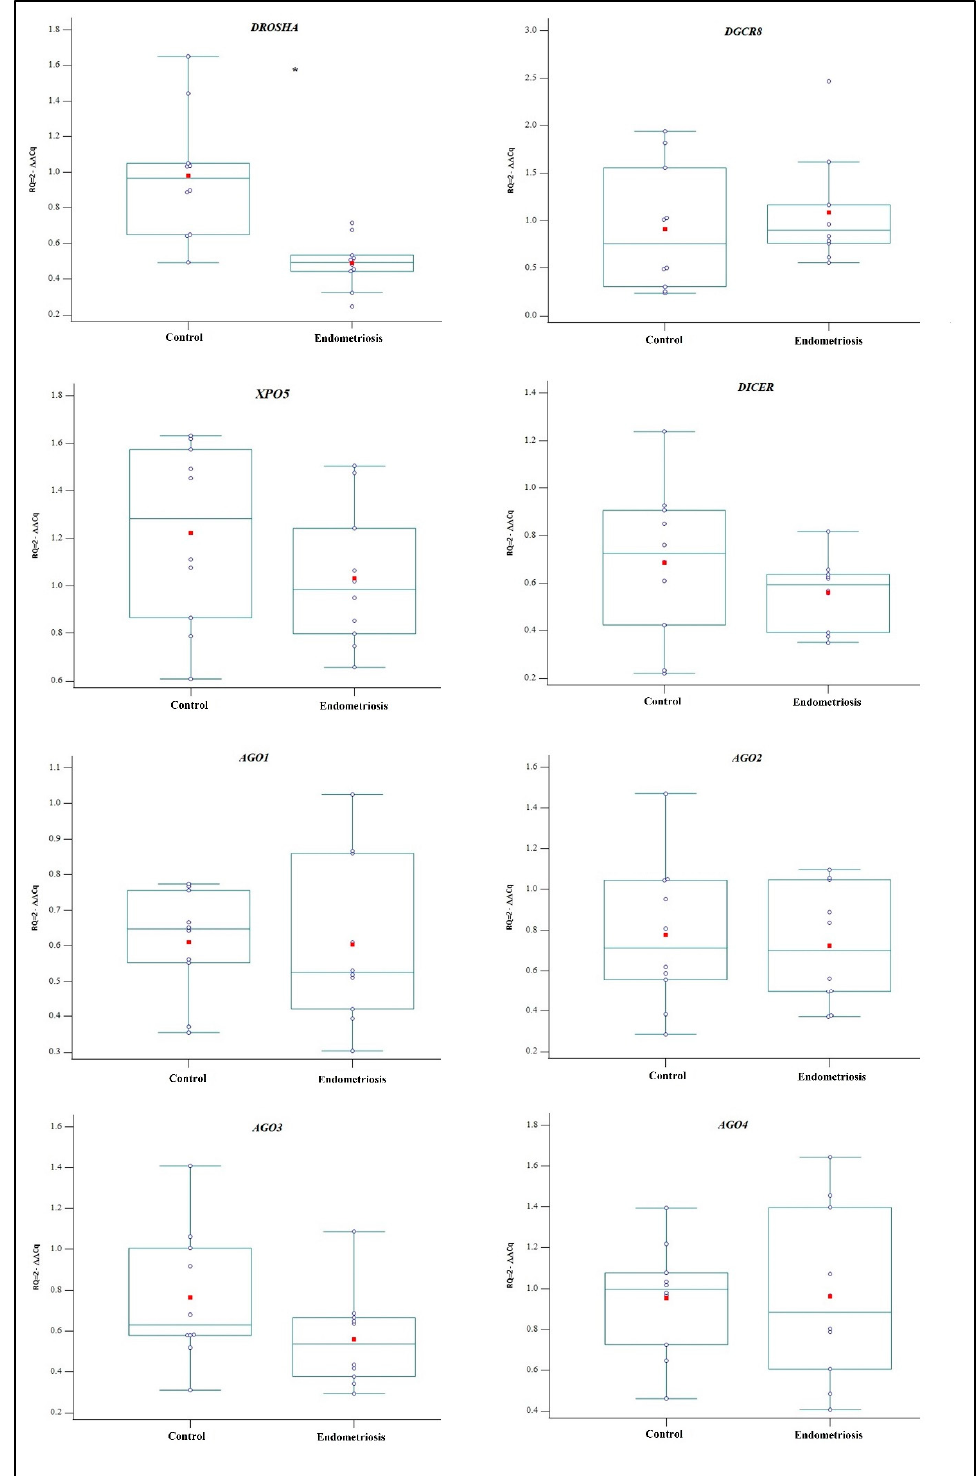
Figure 1. The expression profiles of DROSHA , DGCR8 , XPO5 , DICER , and AGO1 to AGO4 genes were obtained in MenSCs from women with and without endometriosis through RT-qPCR. The dots, red markers, and asterisk represent the raw Cq data of each sample, mean value, and significant differences ( p < 0.05), respectively. Cq = cycle quantification. The box plot was created using MedCalc Statistical Software version 19.5.1 (MedCalc Software Ltd., Ostend, Belgium; https://www.medcalc.org; 2020).